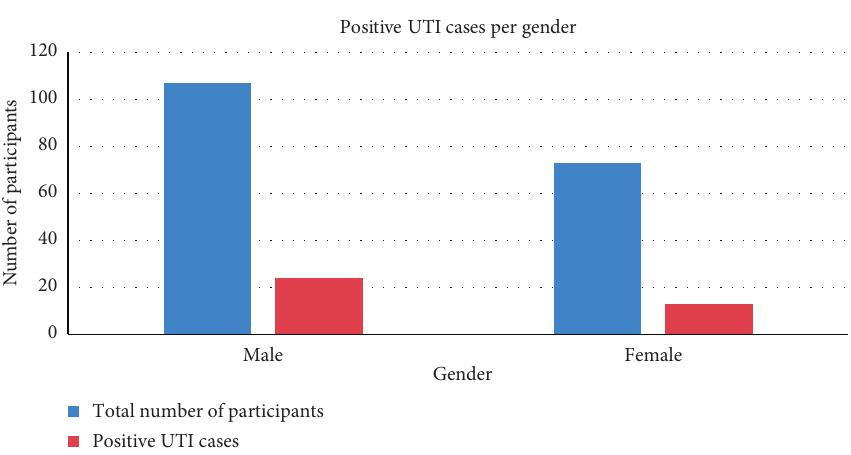
Figure 1: Total number of participants and positive UTI cases per gender.